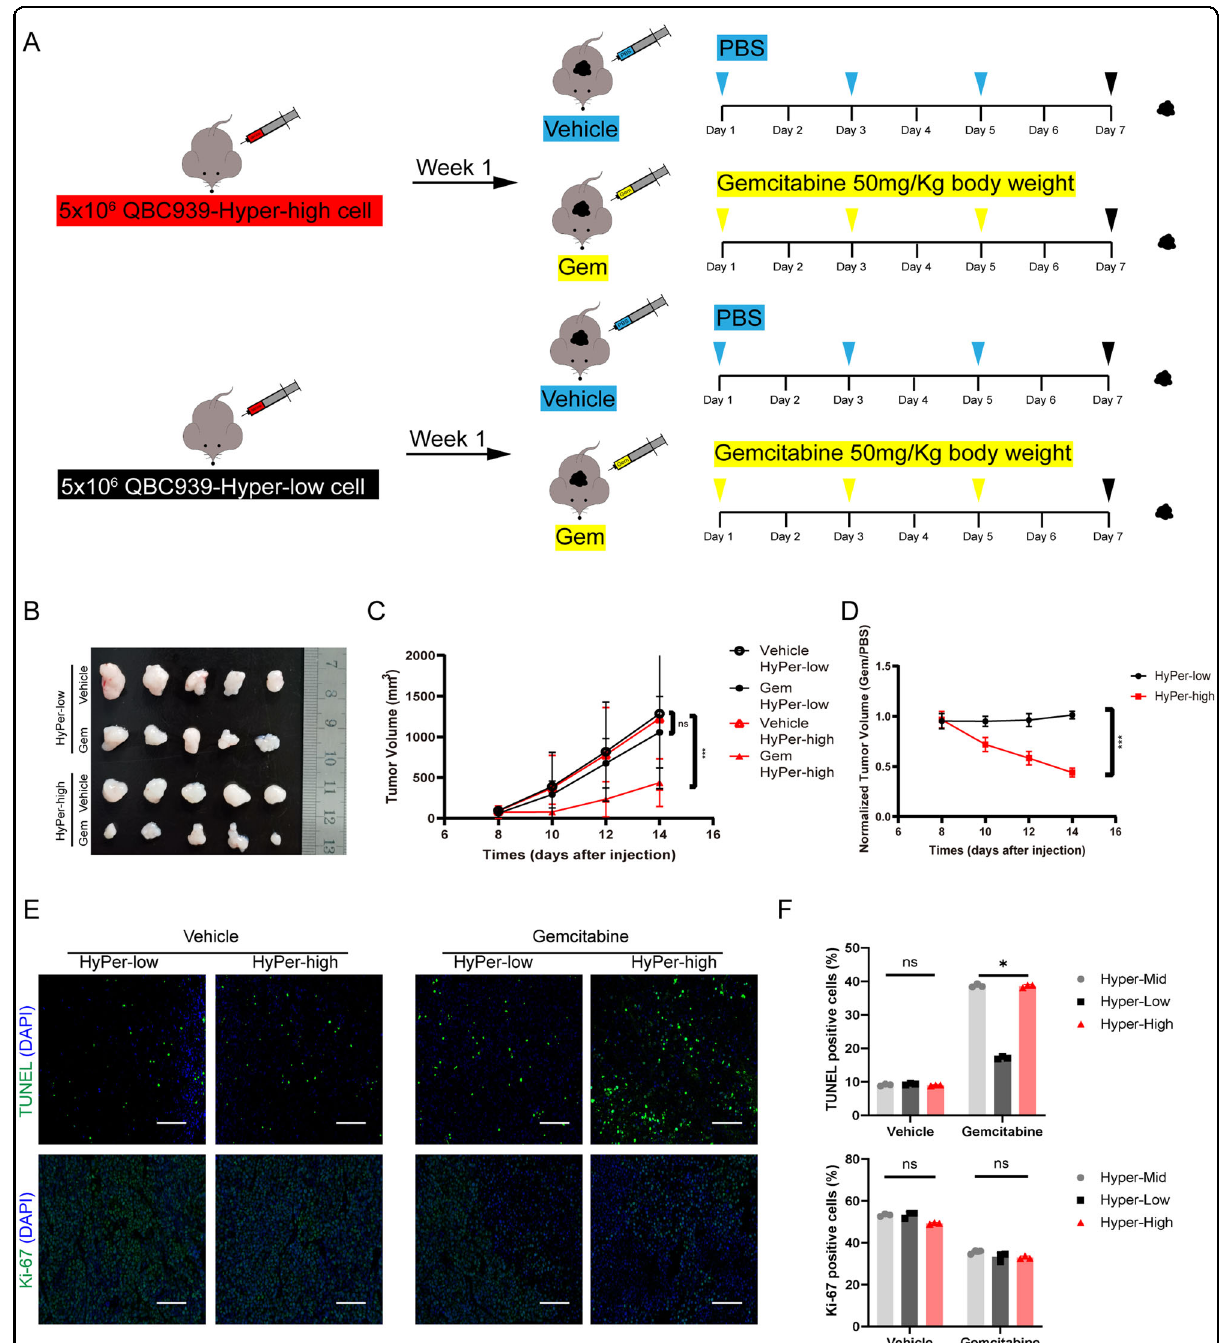
Fig. 3 The different subpopulations of cellular redox status in QBC939 elicited diverse chemoresistance to gemcitabine in the xenograft nude mouse model. A Schematic representation of the in vivo nude mice model. B – D Represent xenograft growth inhibition of different subpopulation of CCA cells under the treatment gemcitabine at the indicated concentration via intraperitoneal injection (i.p.) in QBC939 cell xenografts. E After treatment with gemcitabine, the TUNEL(up) and Ki-67(down) staining in paraf fi n- fi xed xenograft tissue after scari fi cation was detected using immuno fl uorescence staining. F Quanti fi cation of E . * p < 0.05; ** p < 0.01; *** p <